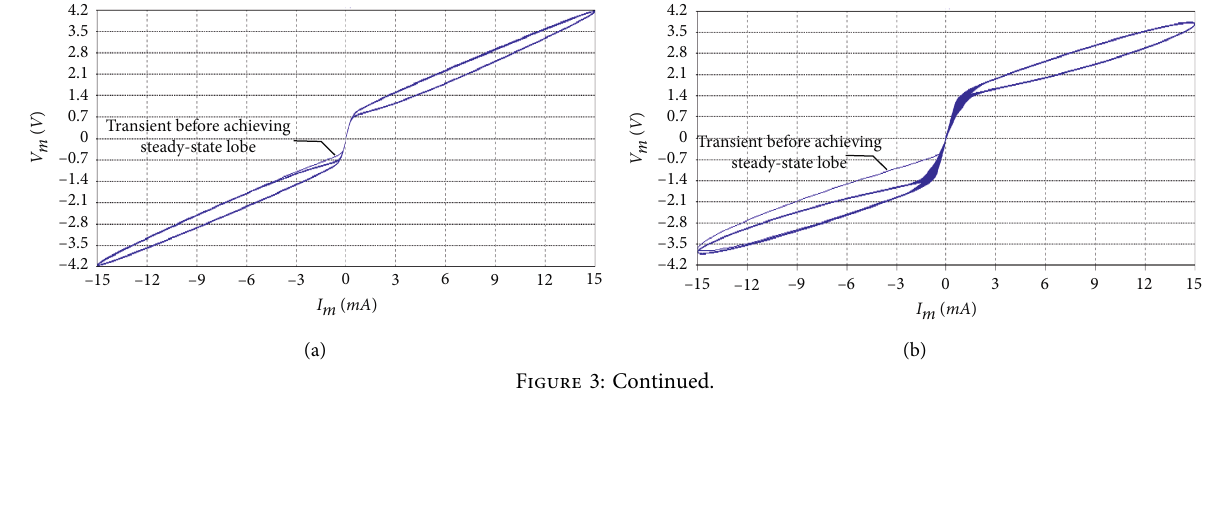
I � 1mA, I � 5mA, I � 10mA, and o values marked in (a): o o o � 15mA to avoid the overwhelming superposition of o